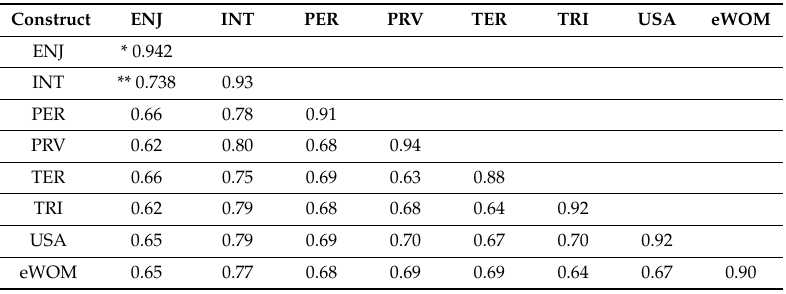
Table 7. Discriminant validity.